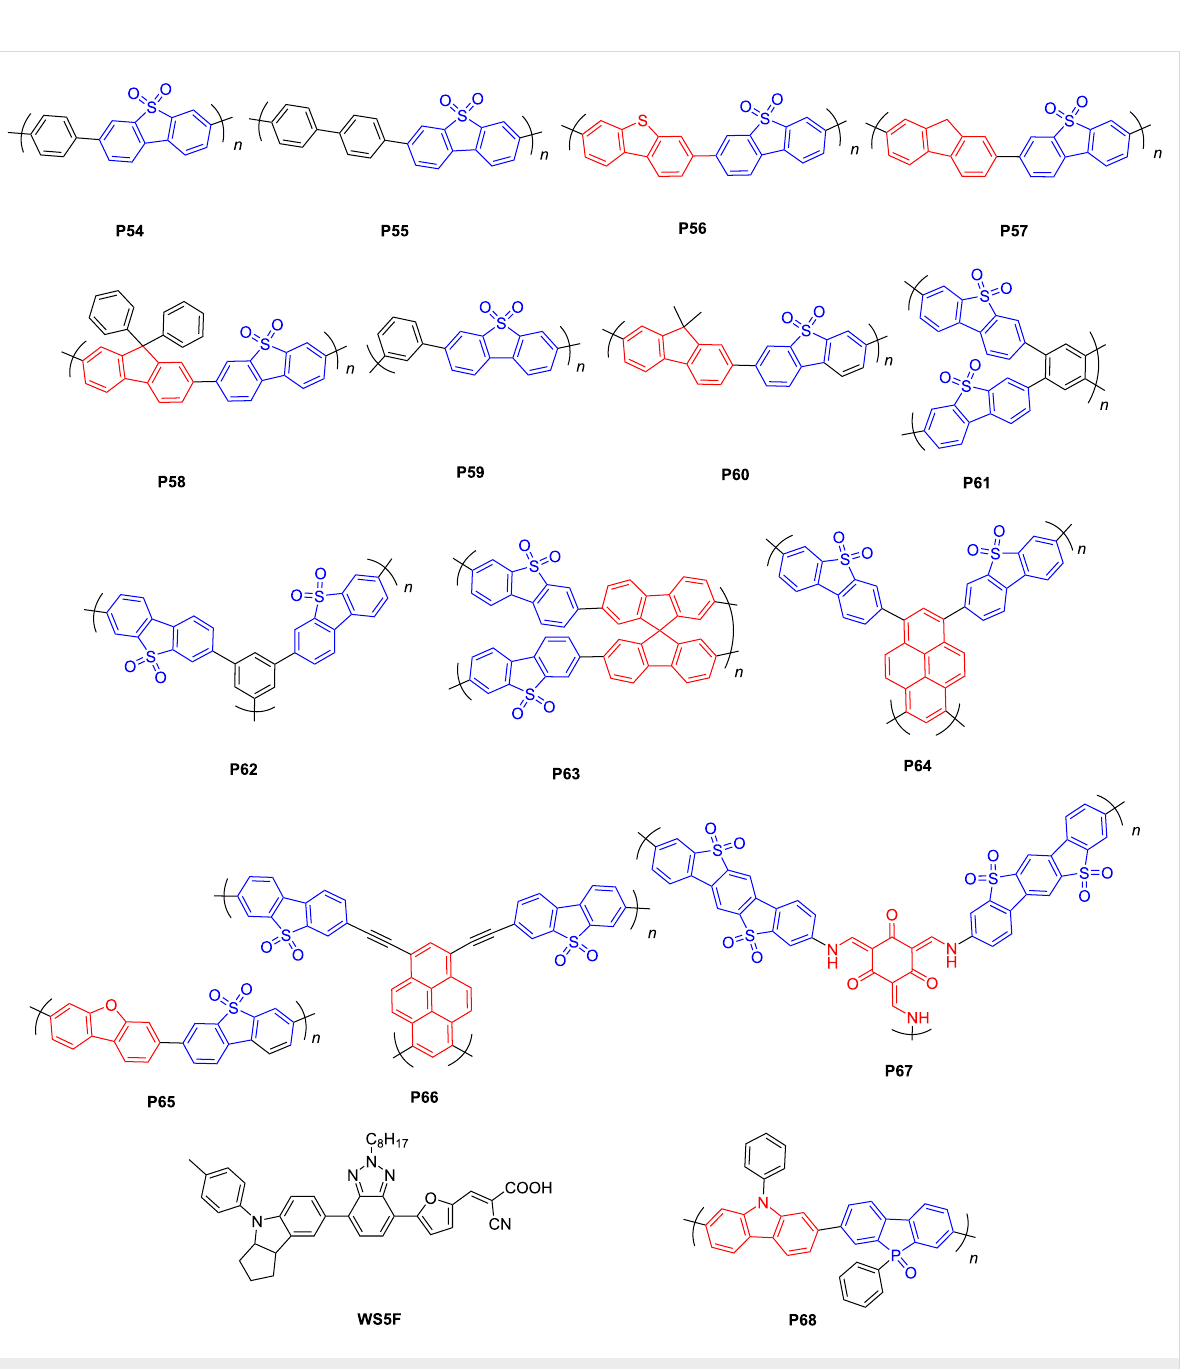
absorption in more planar conjugated systems. Therefore, the fluorene-containing polymer P57 (Figure 8) exhibited the best performance among the three D–A polymers with a HER of 50.4 μ mol·h − 1 (10